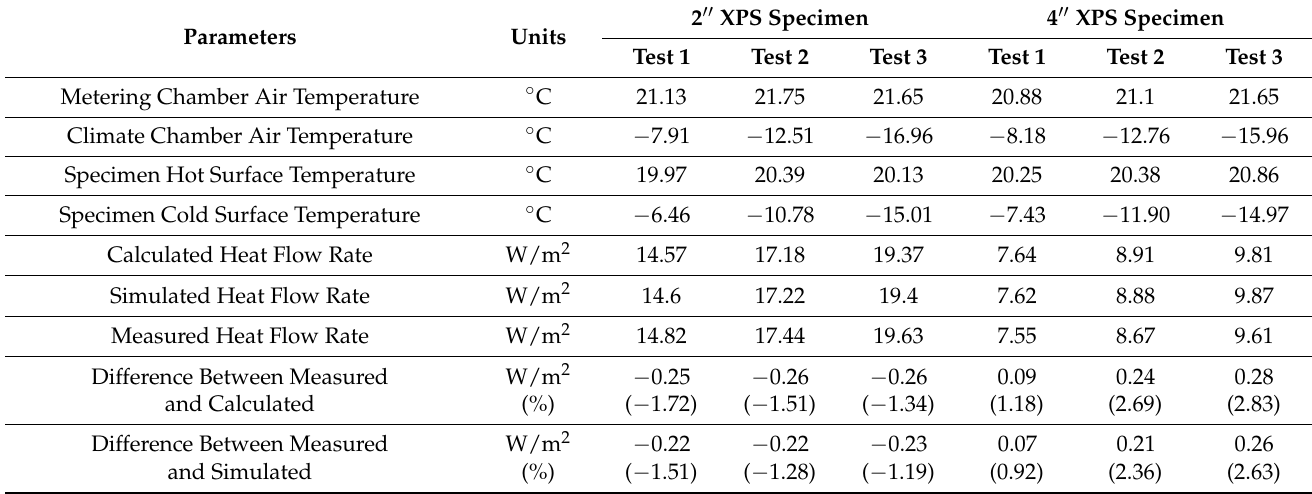
Table 3. Comparison between theoretical, numerical, and experimental heat flow